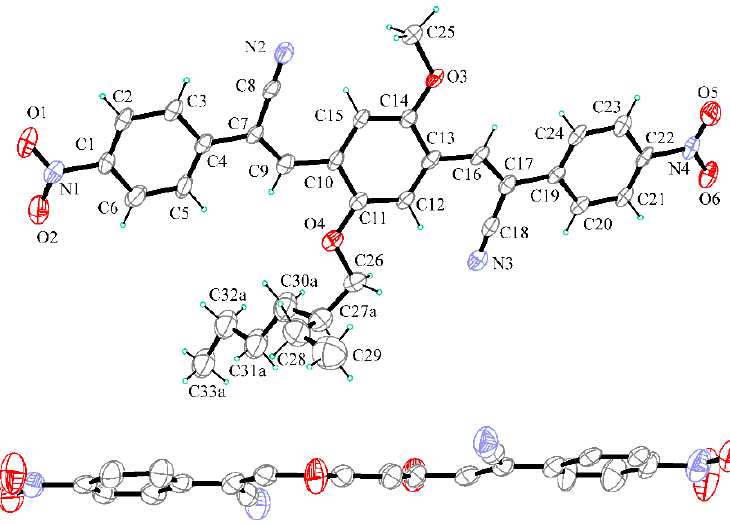
Figure 7. Up: Ortep view of C2 with thermal ellipsoids drawn at 30% probability level. Only major part of disordered alifatic group attached at O4 is reported for clarity. Down: perspective view in the edge of C10 / C15 ring (H atoms and alkyl groups at O3 and O4 are not shown for clarity).